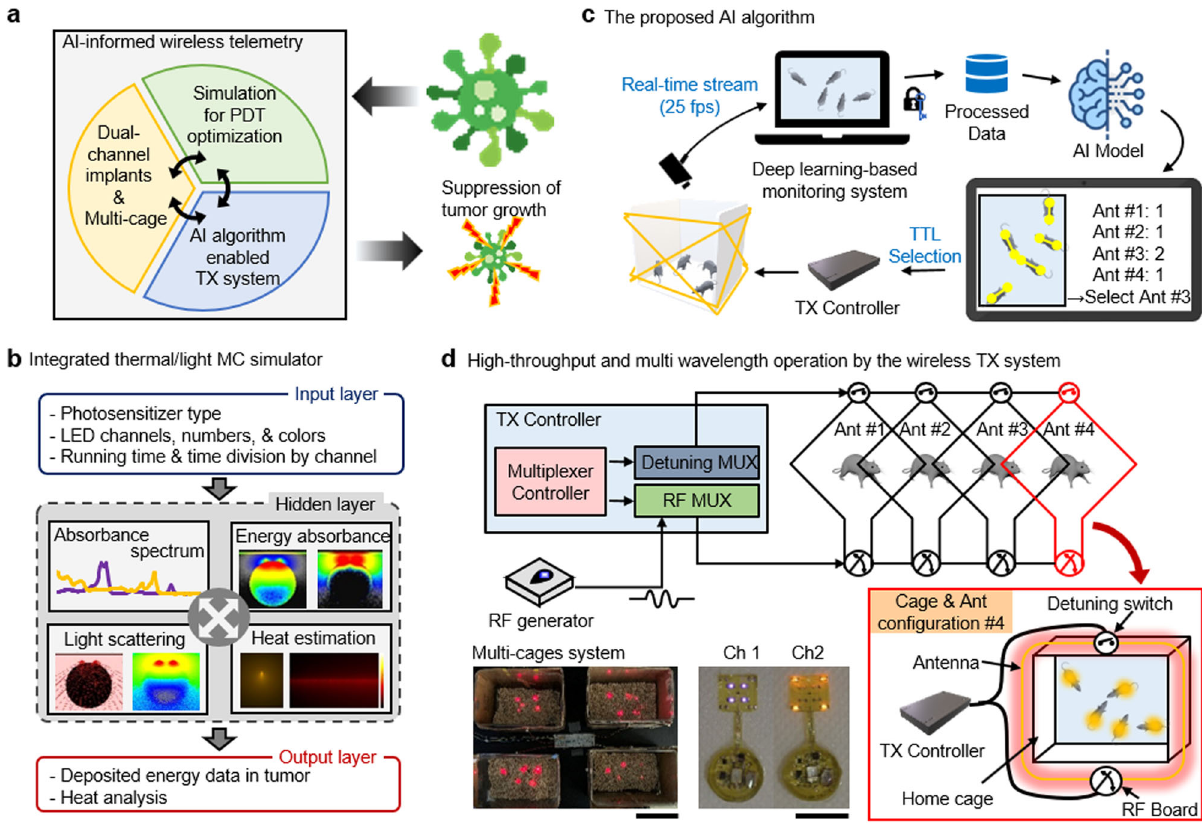
Fig. 1 Summary of AI-enabled, implantable, multichannel wireless telemetry for PDT. a Overview of the proposed integrated platform. b Work fl ow for an integrated MC simulator for analysis of heat dissipation and light propagation. c The proposed AI-based algorithm for real-time monitoring of mice. d Schematic illustration of the low-power wireless telemetry system for multi-wavelength operation (top). Two images represent demonstration of multichannel activation using a single power source (bottom, left) and multi-wavelength operation (bottom, right); scale bar 10 cm (left) and 1 cm